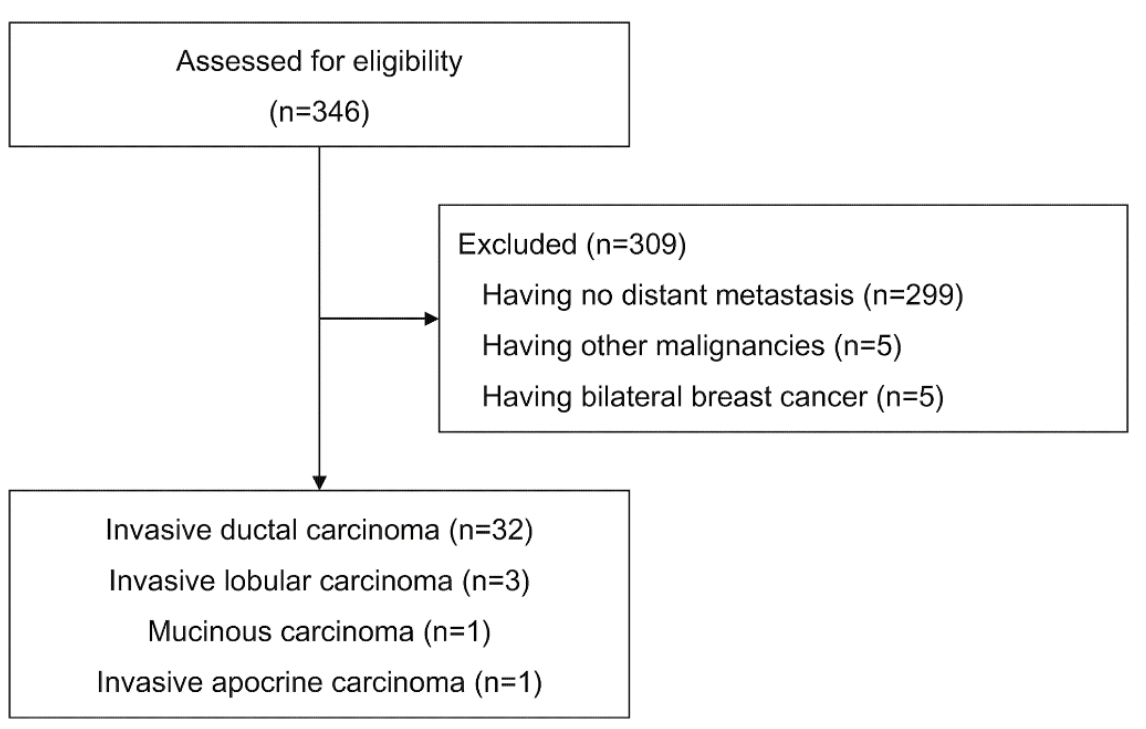
Figure 1. Flow diagram for patient inclusion.